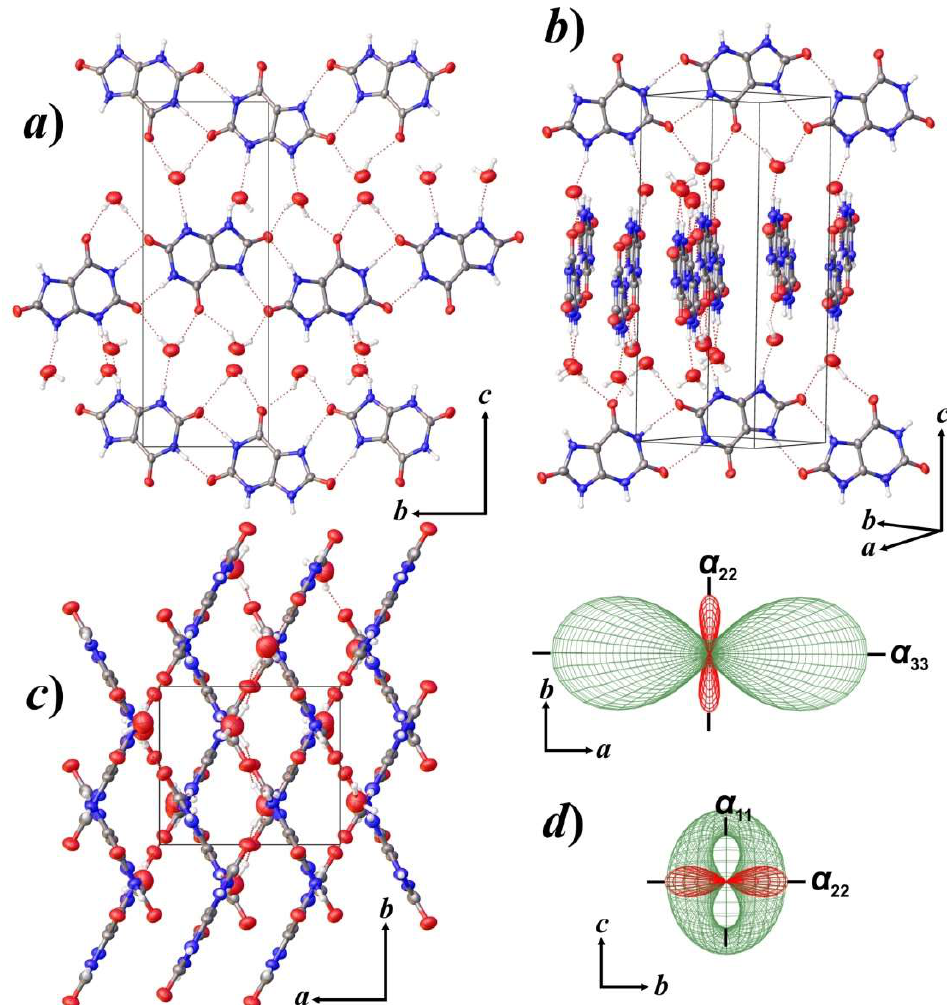
Figure 5. Crystal structure of UAD, projections along the ( a ) [100], ( b ) [210], and ( c ) [001] directions; and ( d ) the arrangement of figure of thermal expansion/contraction coefficients in the structure of UAD. Legend is the same as in Figure 2; figures of TEC: expansion = green, contraction = red.